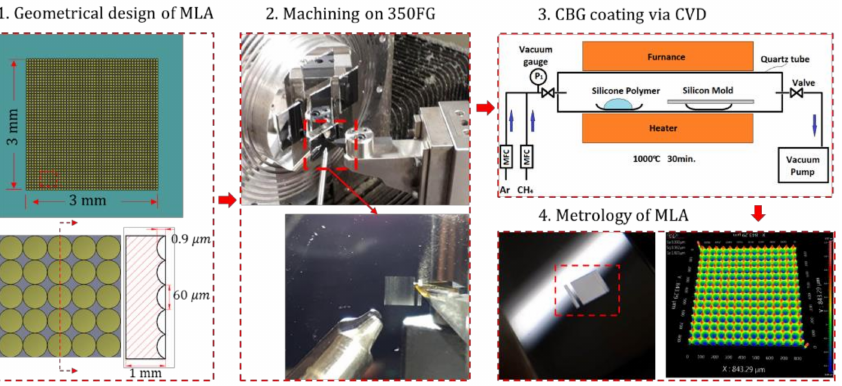
Figure 5. Fabrication process of CBG-coated silicon wafer mold with